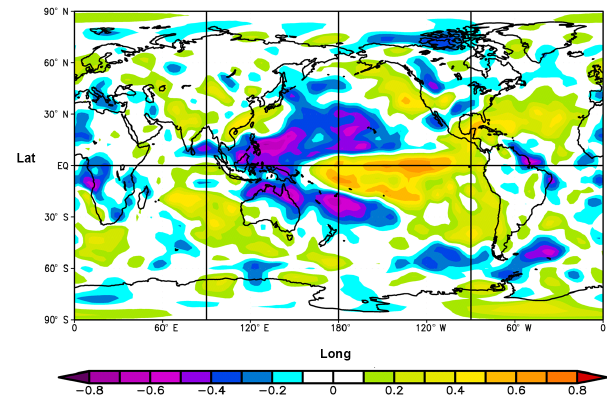
Figure 4. Correlation of vertical velocity ω (Pas − 1 ) at 300hPa with SOI for February–April and